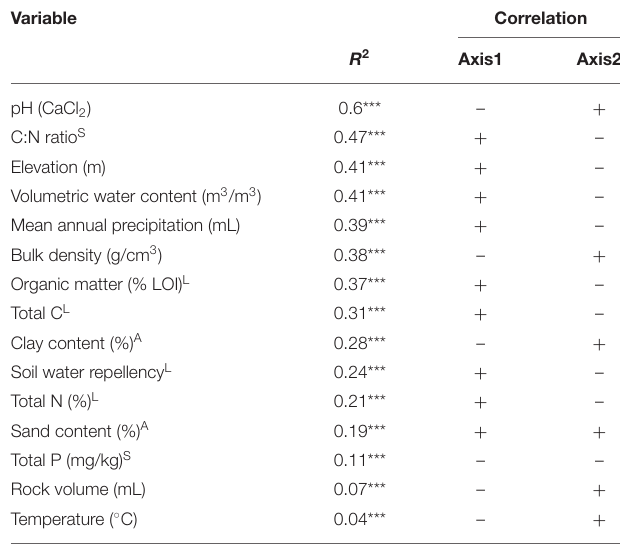
TABLE 3 | Summary of relationships amongst environmental factors and fungal communities based on ITS data.